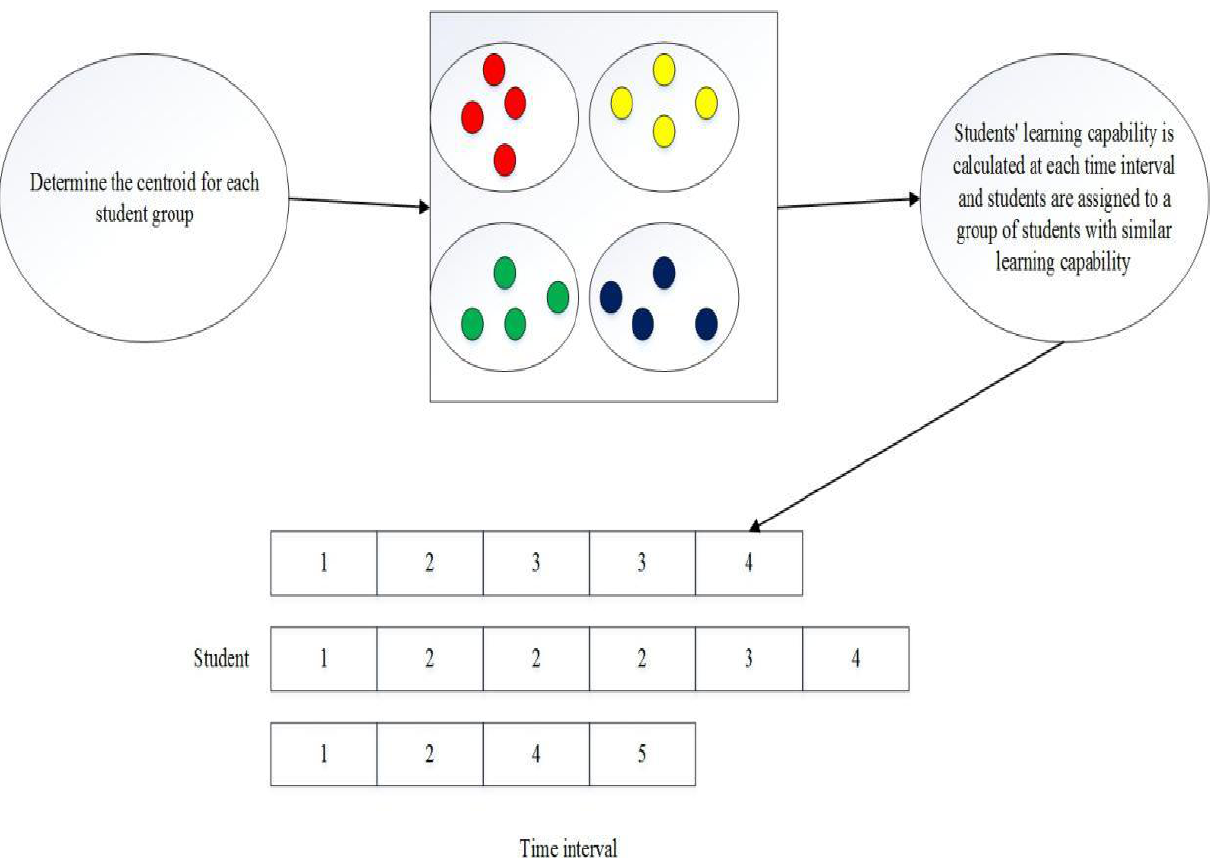
Figure 2. Grouping of students’ learning capability at every time interval.